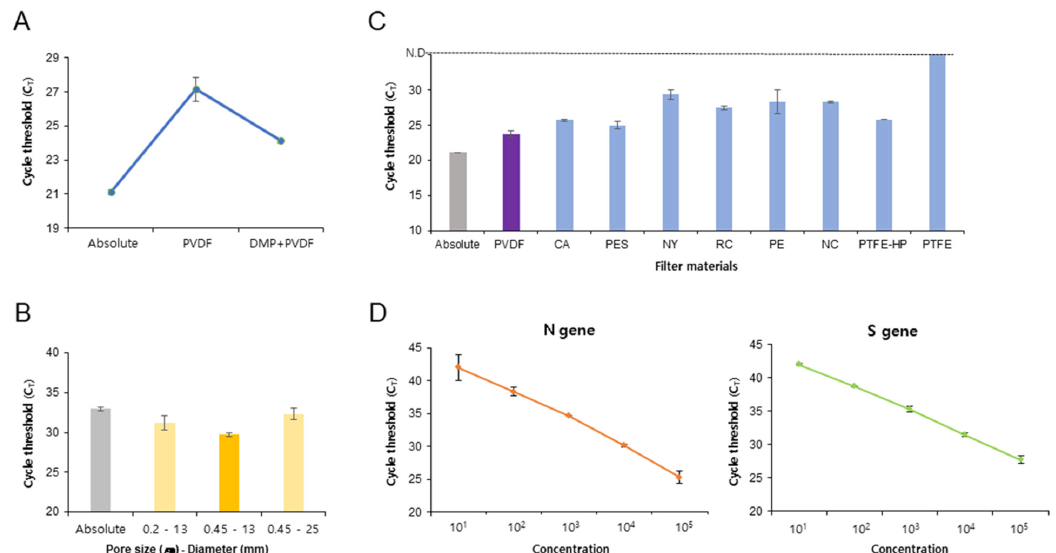
Figure 2. Application of DMP-PVDF filter platform to pathogen enrichment and extraction. ( A ) The amplification efficiency for a sample of E. coli (10 5 CFU/mL) following bacterial enrichment and extraction using the DMP-PVDF platform is dependent on DMP. The positive control is DNA extracted from 10 5 CFU of E. coli using a Qiagen kit. The data are presented as mean ± SD, based on at least three independent experiments. ( B ) The E. coli capture rate of the DMP-PVDF platform depends on the filter membrane’s pore size and diameter. The positive control (gray) is E. coli DNA extracted from 10 5 CFU of E. coli using a Qiagen kit. The nearest and safest value to control (0.45 µ m–13 mm) is marked in deep yellow. ( C ) The E. coli capture rate of the new platform depends on the type of filter membrane. The PVDF membrane (purple) shows the nearest and safest value to control. ( D ) Capacity of the DMP-PVDF filter platform to process test SARS-CoV-2 culture fluid ranging from 1 × 10 1 to 1 × 10 5 PFU/100 µ L using a Qiagen kit. SARS-CoV-2 viral loads were quantified using RT-qPCR assay targeting the N and S genes. The data are presented as mean ± SD, based on at least three independent experiments. DMP, dimethyl pimelimidate; PVDF, polyvinylidene fluoride; N, nucleocapsid; S, spike; SD, standard deviation.